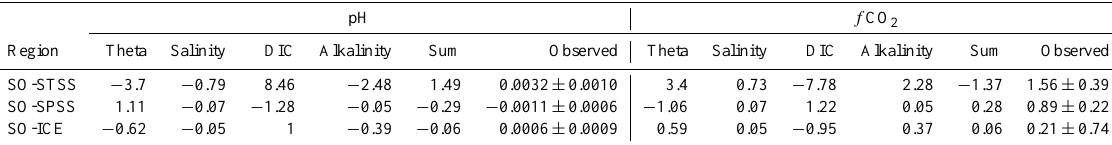
Table 3. Decomposition of the 2001–2011 f CO 2 and pH insitu trends in the Southern Ocean into their major drivers. The units are µatmyr − 1 and 10 − 3 pH unitsyr − 1 respectively. Observed pH trend is in pH units per year.